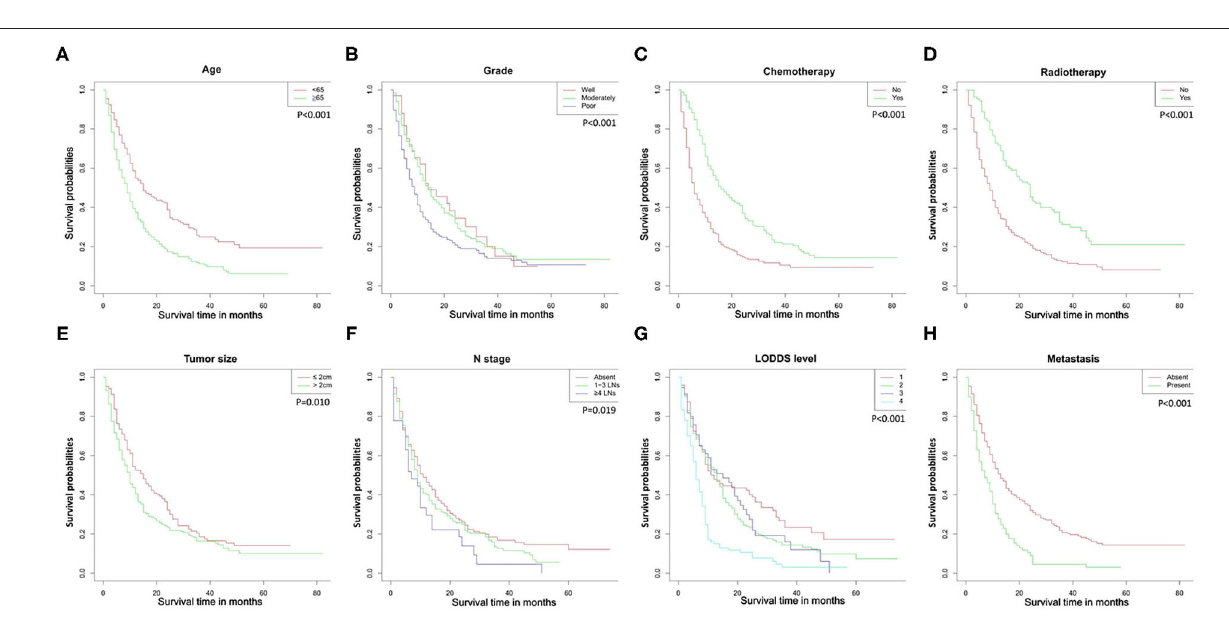
Frontiers in Surgery |